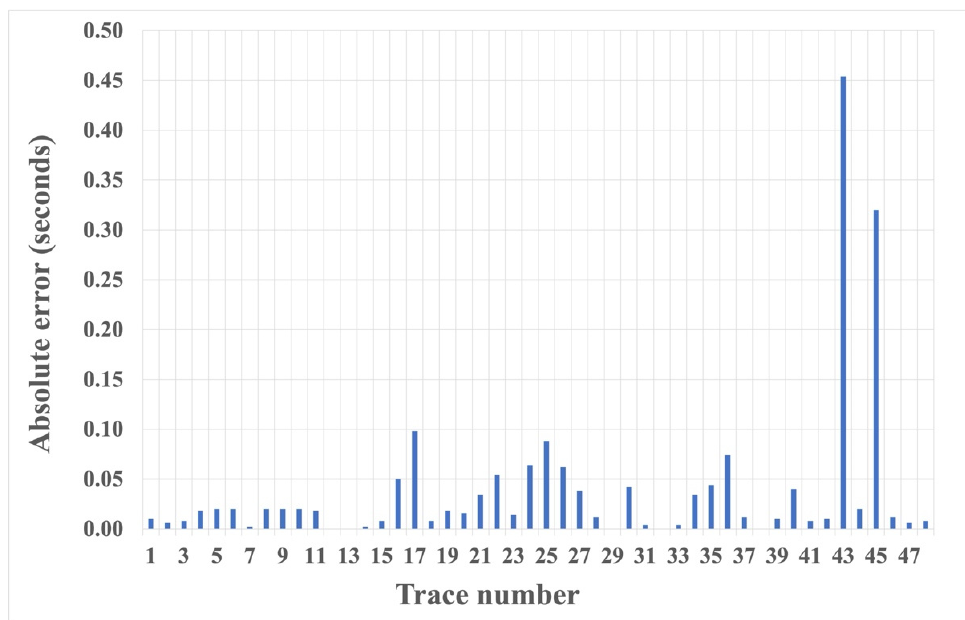
Figure 14. Yilmaz record number 23 first arrival picks determined by the HEEH method and manually.